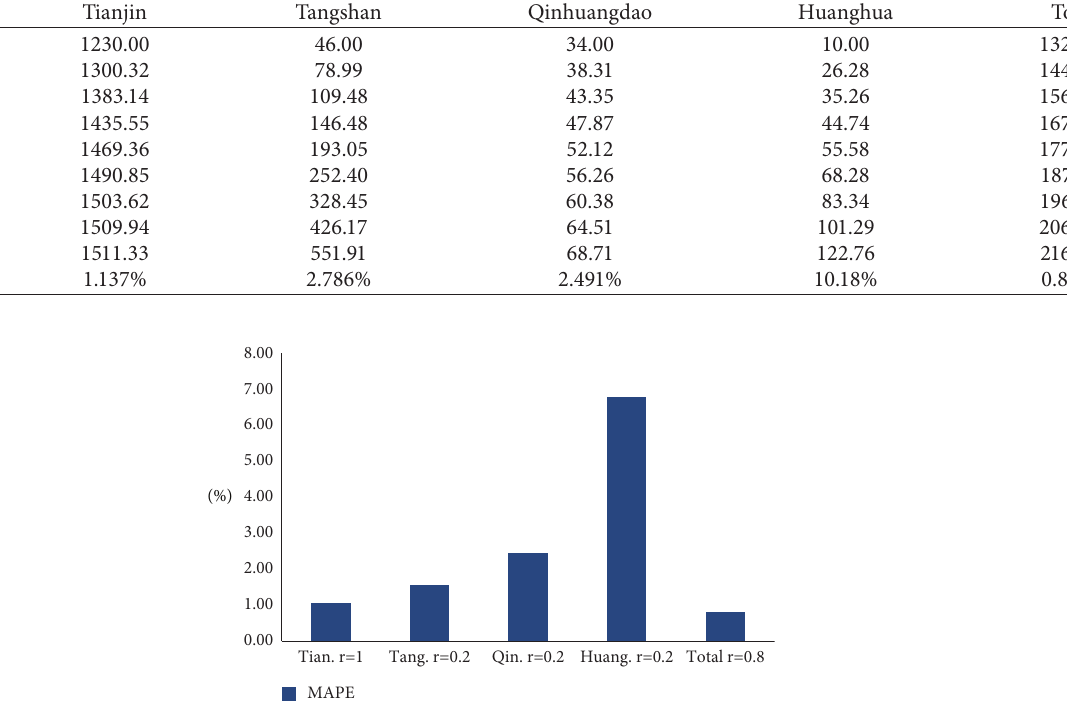
Table 4: FGM (1.1) when r � 0 . 8 container throughput of Tianjin-Hebei Port Group (unit: 10,000TEU).